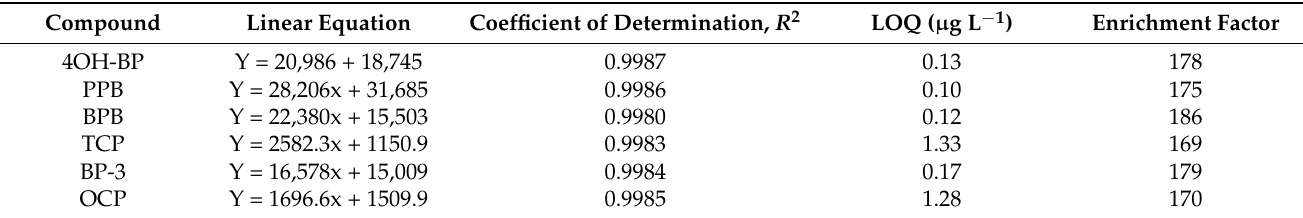
Table 1. Analytical figures of merit of the developed analytical